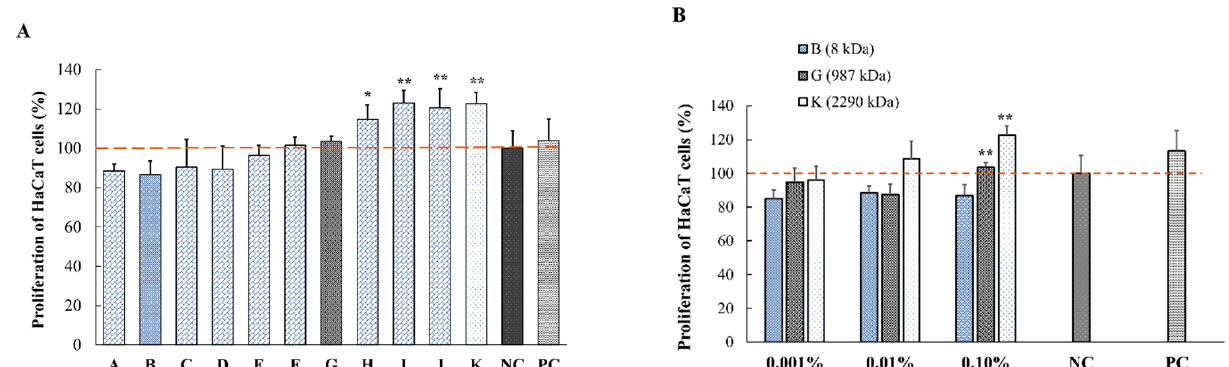
Figure 2. In vitro effect of HA with different MWs on the proliferation of HaCaT cells. ( A ) Incubation of HaCaT cells with 0.1% solutions of HA with different MW (HA-A:2, B:8, C:75 HA-D:300, E:619, F:800, G:987, H:1300, I:1530, J:1810 and K:2290 kDa) in complete DMEM for 48 h. Control groups include a negative control (NC group, 1% FBS-DMEM) and a positive control (PC group, 10% FBS-DMEM. The percentage of proliferation was calculated as the viability normalized to the NC group. ( B ) Incubation of HaCaT cells with 0.001%; 0.01% and 0.1% HA-B, -G and -K solutions (diluted in 1% FBS-DMEM) for 48 h (* p < 0.05, ** p < 0.01 vs. NC group using Dunnet’s test ( n = 5)).